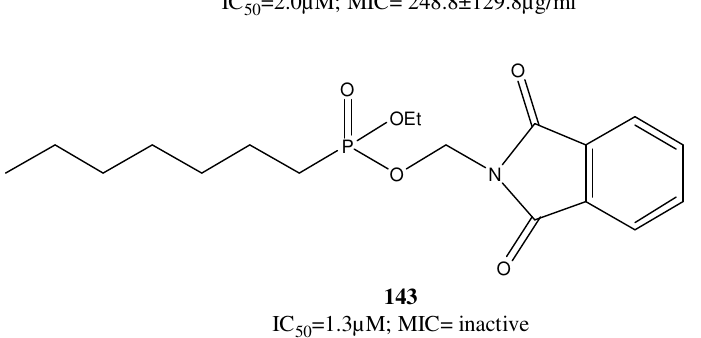
FIGURE 15. Structures of compounds 142 and 143